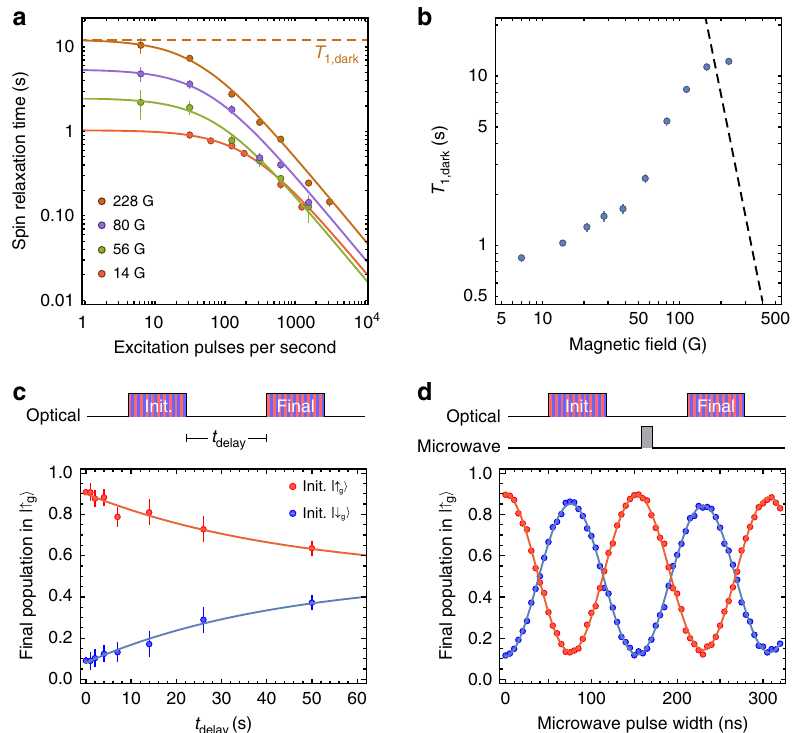
Fig. 4 Spin dynamics of a single Er 3 + ion. a Spin relaxation times measured at varying repetition rates of the pulse sequence for several magnetic fi eld amplitudes [( φ , θ ) = (100, 90)°]. At low excitation rates, the spin relaxation time becomes independent of the optical excitation rate, revealing an intrinsic relaxation time T 1,dark . b T 1,dark varies strongly with the amplitude of the magnetic fi eld. The dashed line indicates the expected spin-lattice relaxation rate (Supplementary Note 6) 39 . c Using a single-shot projective measurement to initialize the spin, we can directly measure T 1,dark . This experiment is performed on a different ion (ion 3) at 112 G, where T 1,dark = 45 ± 4 s is roughly fi ve times longer than in the ion used ( a , b ). d Rabi oscillations can be observed between the two states using a microwave pulse of variable length ( f MW = 1.76 GHz for B = 112 G). c , d The contrast is consistent with a measurement fi delity of ~95% for this ion, which enters twice through the initial and fi nal